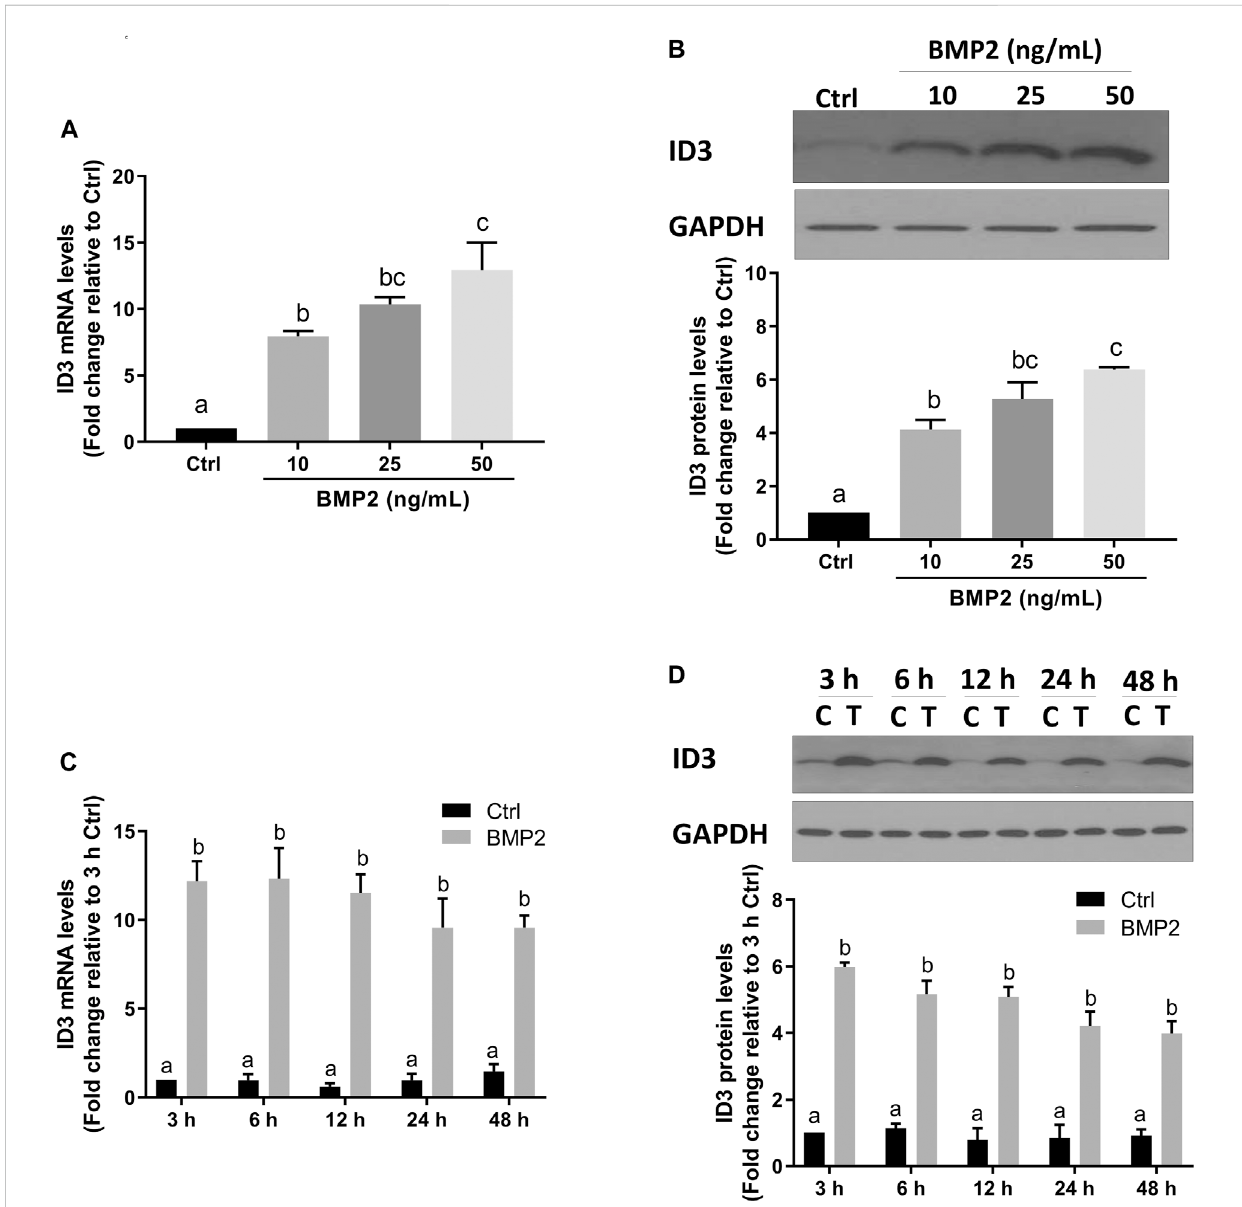
FIGURE 5 BMP2 upregulates the expression of ID3 by BMP2 in HDSCs. (A and B) HDSCs were treated with different concentrations (0, 10, 25, 50 ng/mL) of recombinanthumanBMP2for24 h,andthemRNA (A) andprotein (B) levelsofID3wereexaminedusingRT-qPCRandWesternblotanalysis,respectively. (C,D) HDSCs were treated with 25 ng/mL of BMP2 for 3, 6, 12, 24 or 48 h, and the mRNA (C) and protein (D) levels of ID3 were examined using RT-qPCR and Western blot analysis, respectively. The results are expressed as the mean ± S.E.M. of at least three independent experiments. Different letters indicate a signi fi cant difference ( p <